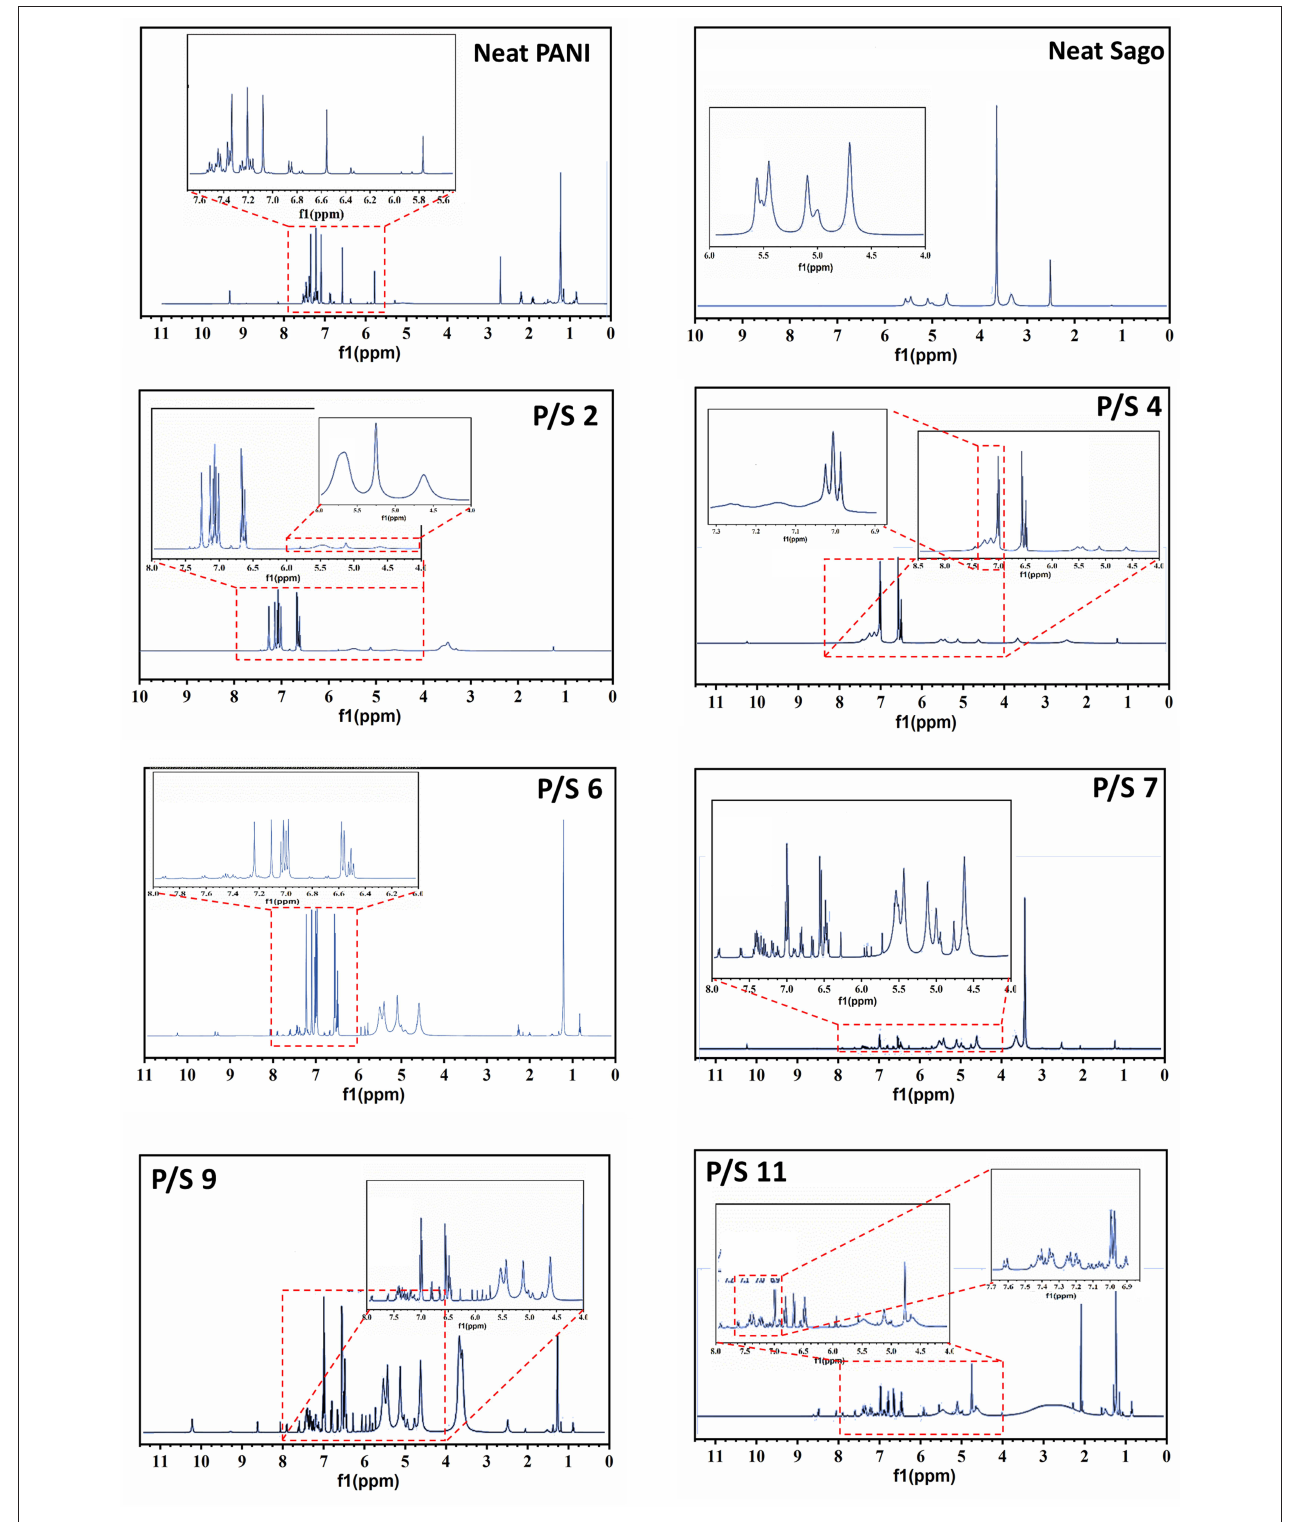
FIGURE 2 | 1 H NMR of Neat PANI, Neat Sago and PANI/Sago blends of varying pH.